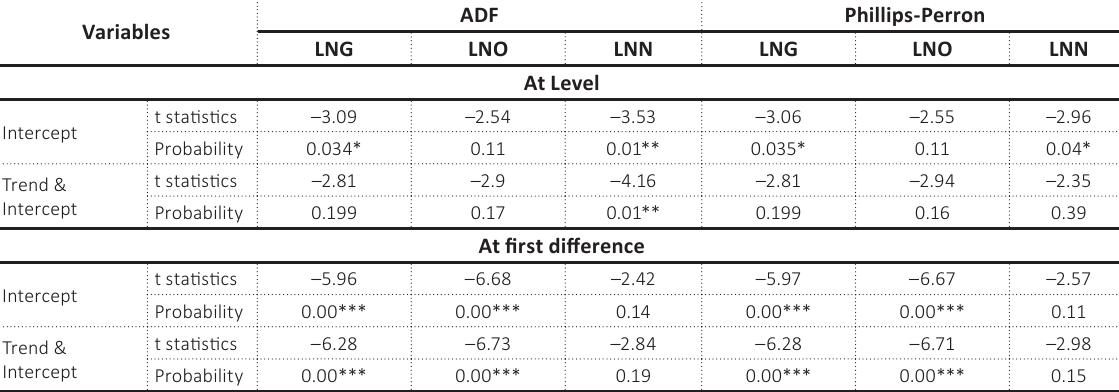
Table 3. Unit root test